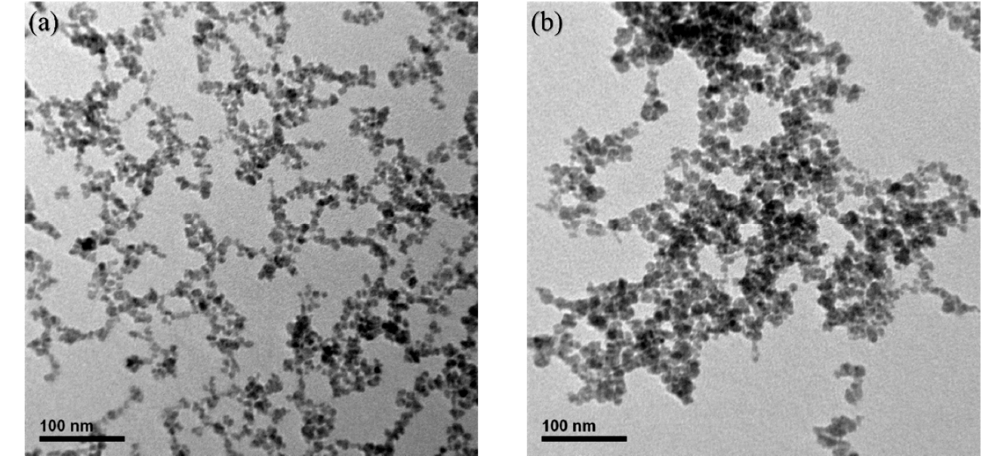
Figure 2. Characterization of ( a ) magnetic nanoparticles (MNPs) and ( b ) monocytes chemoattractant protein-1 (MCP-1)-motif MNPs using TEM.